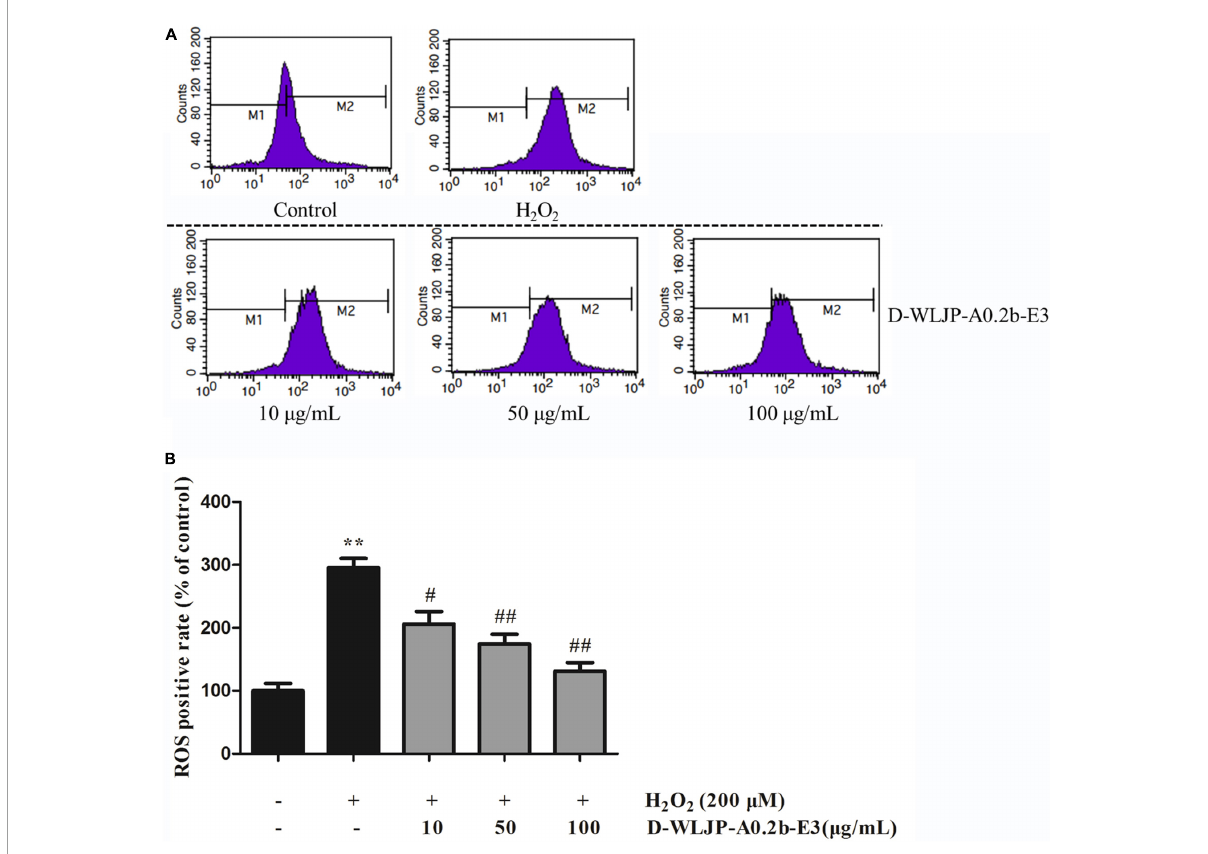
FIGURE7 Effects of D-WLJP-A0.2b-E3 treatment at different concentrations on H 2 O 2 -induced intracellular accumulation of reactive oxygen species (ROS) in HEK-293T cells. (A) The intracellular levels of ROS analyzed by flow cytometry. (B) Histogram analysis of intracellular accumulation of ROS. Data are presented as means ± SD from three independent experiments. ** p < 0.01 vs. the control group, # p < 0.05 vs. H 2 O 2 model group, and ## p < 0.01 vs. H 2 O 2 model